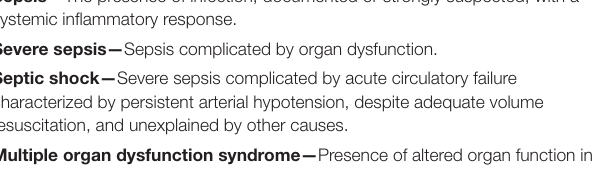
TABLE 2 | SCCM/ESISM/ACCP/ATS/SIS sepsis definitions (2001). SCCM/ESICM/ACCP/ATS/SIS sepsis definitions Sepsis— The presence of infection, documented or strongly suspected, with a systemic inflammatory response. Severe sepsis— Sepsis complicated by organ dysfunction.